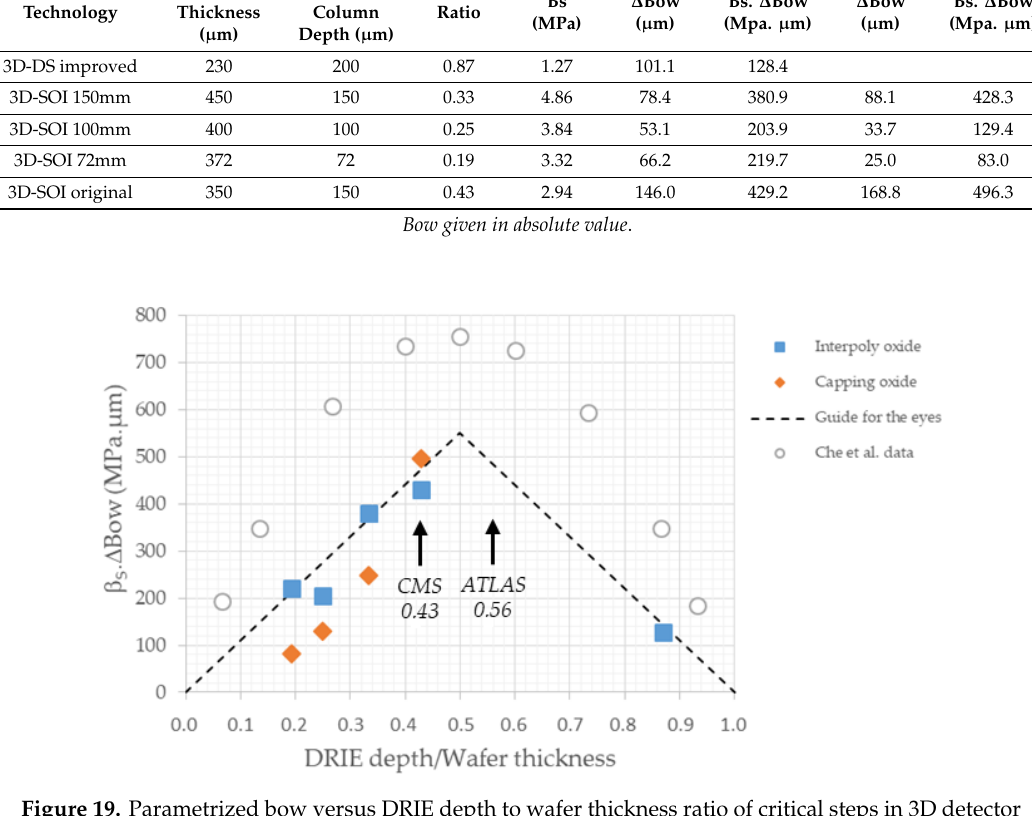
Table 3. Estimation of parametrized bow in critical steps of 3D technologies.